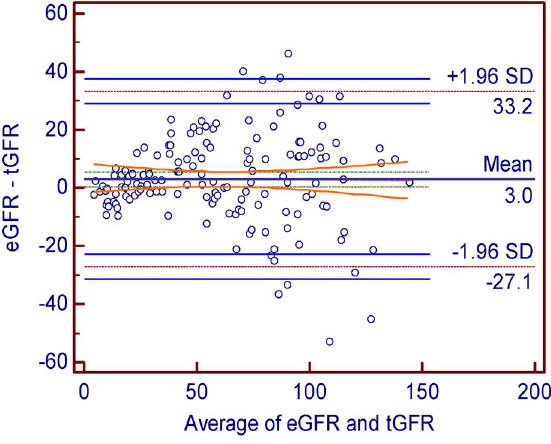
Figure 4. Bland-Altman plot showing the disagreement between dGFR or eGFR and tGFR. The solid long line indicates the mean of difference and the dotted long line represents the 95% limits of agreement. Abbreviations: eGFR- the GFR estimated by CDK- EPI equation method, tGFR- the GFR measured by dual plasma sampling